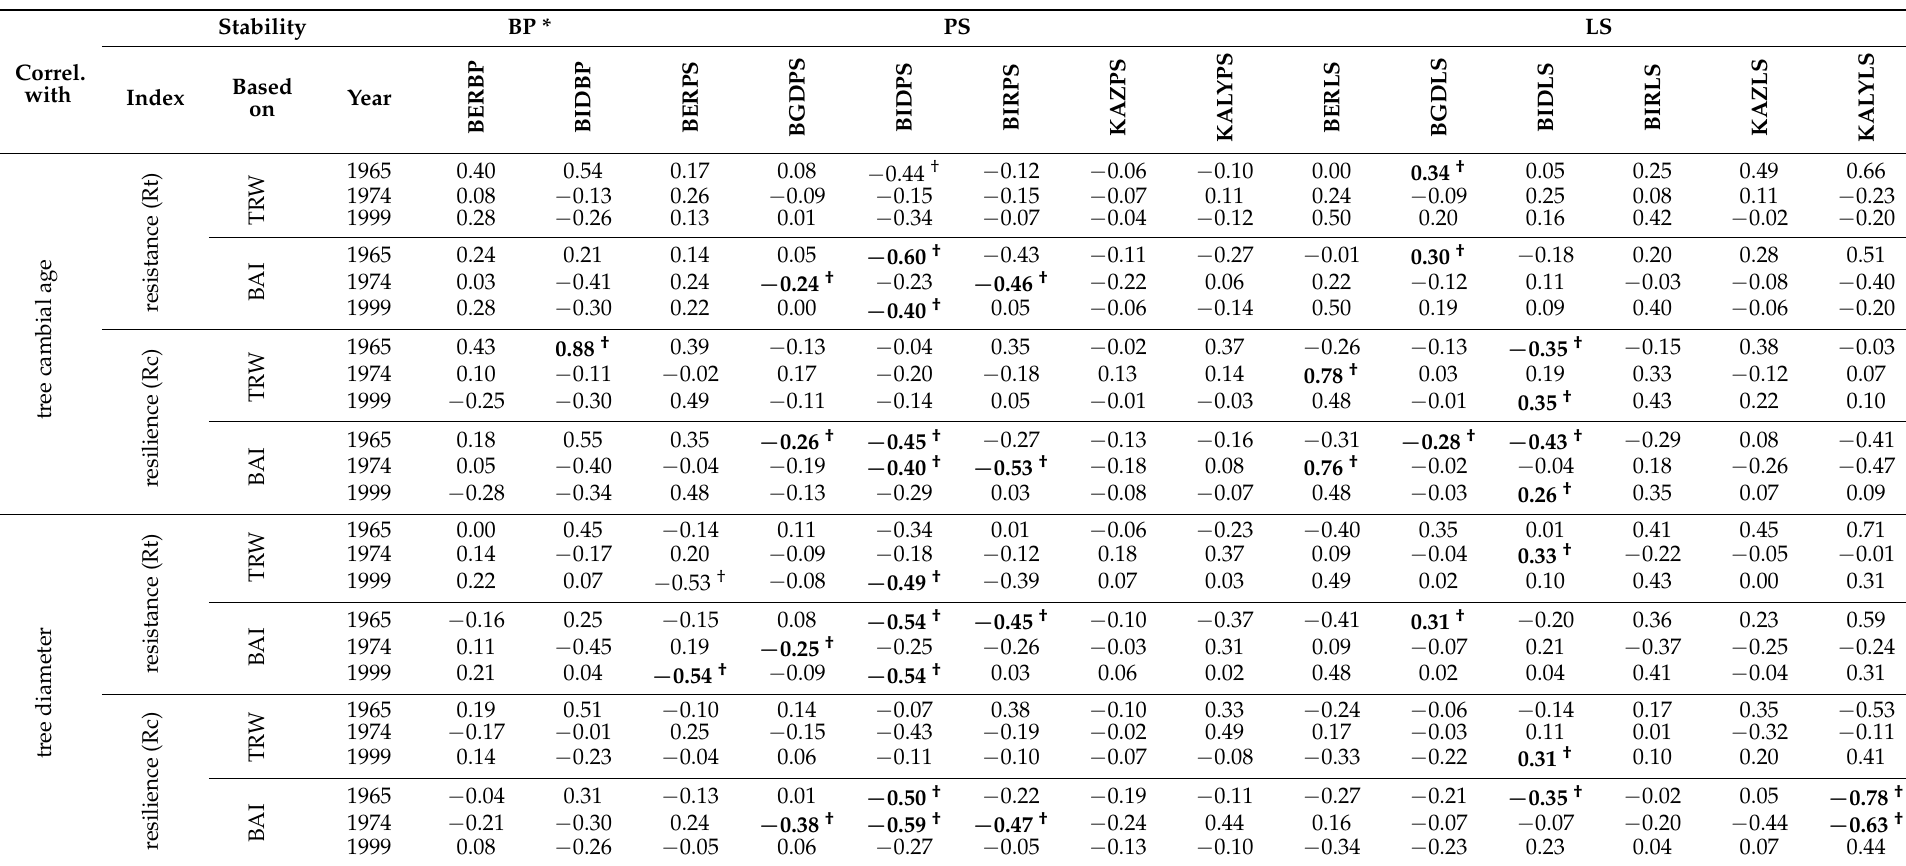
Table 3. Correlation coefficients of individual tree drought-related growth stability indexes: resistance (Rt) and resilience (Rc) measured for droughts in 1965, 1974, and 1999, with individual tree cambial age, diameter, and basal area. Stability indexes were calculated based on the raw tree-ring width (TRW) and basal area increment